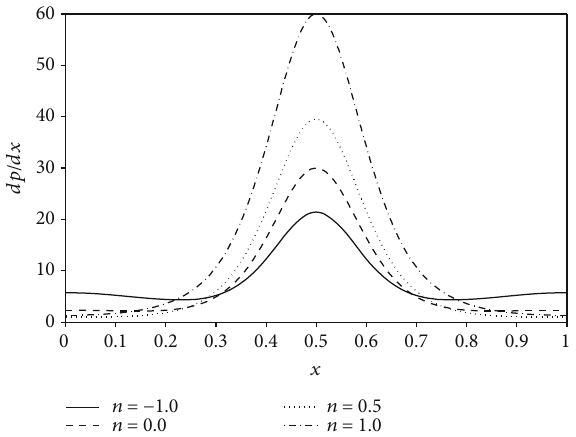
Figure 8: Variation of pressure gradient with x for di ff erent values of We for fi xed values of φ = 0 : 5 , β = 4 , n = 0 : 5 , and Q = − 2 .